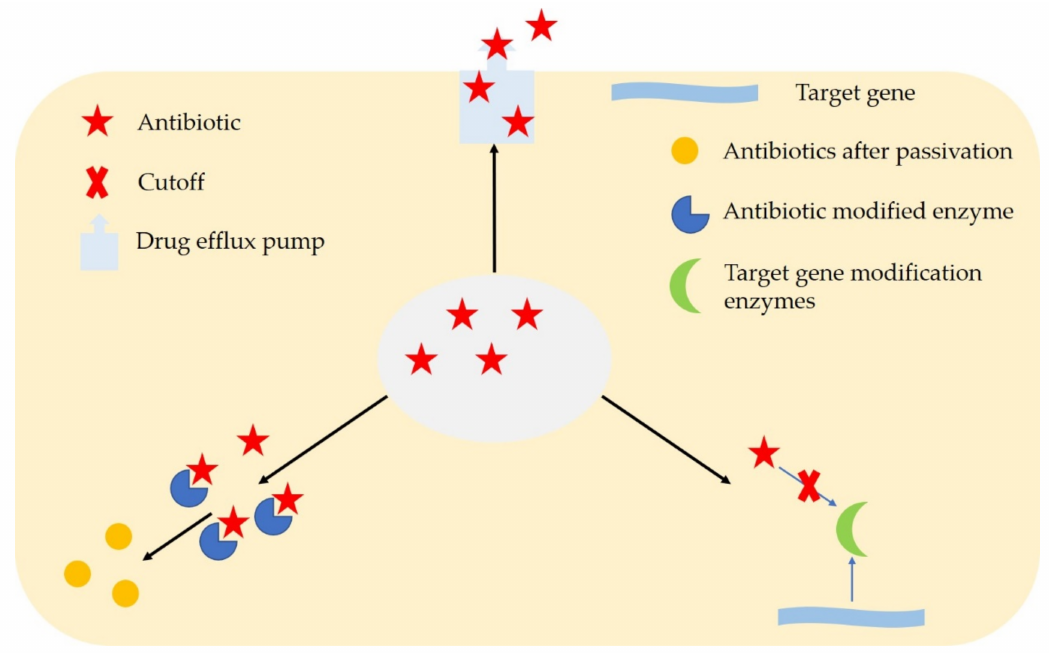
Figure 1. Common mechanisms of microbial